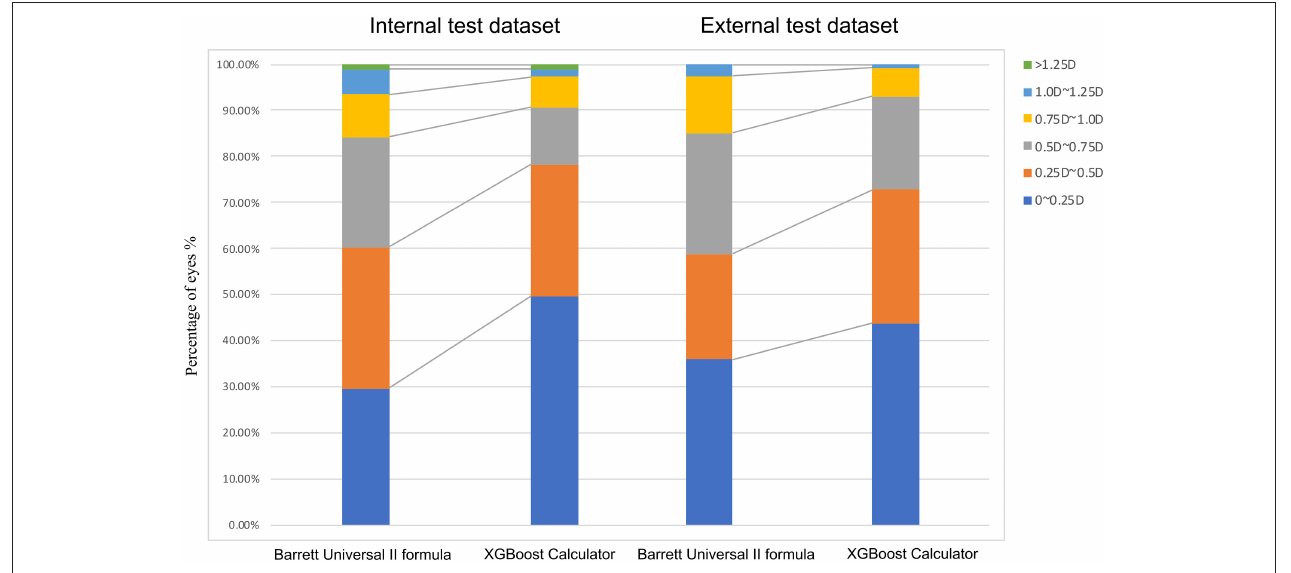
FIGURE 3 | Distribution of eyes within ± 0.25 D, ± 0.50 D, ± 0.75 D, ± 1.00 D, or ± 1.25 D of the prediction errors in the internal test